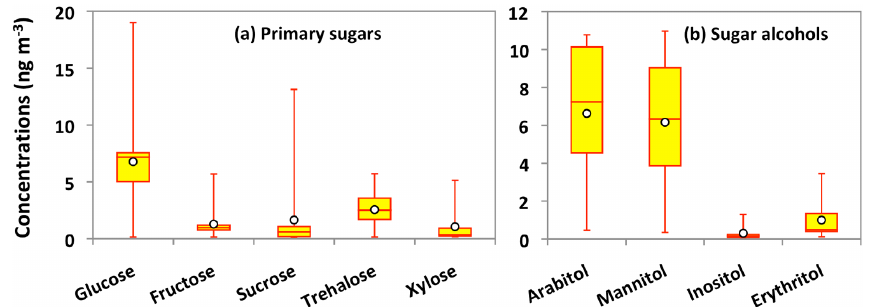
Figure 9. Molecular distributions of primary sugars and sugar alcohols in PM 2 . 5 aerosols collected in central Alaska. See Fig. 5 for the description of the box-and-whisker